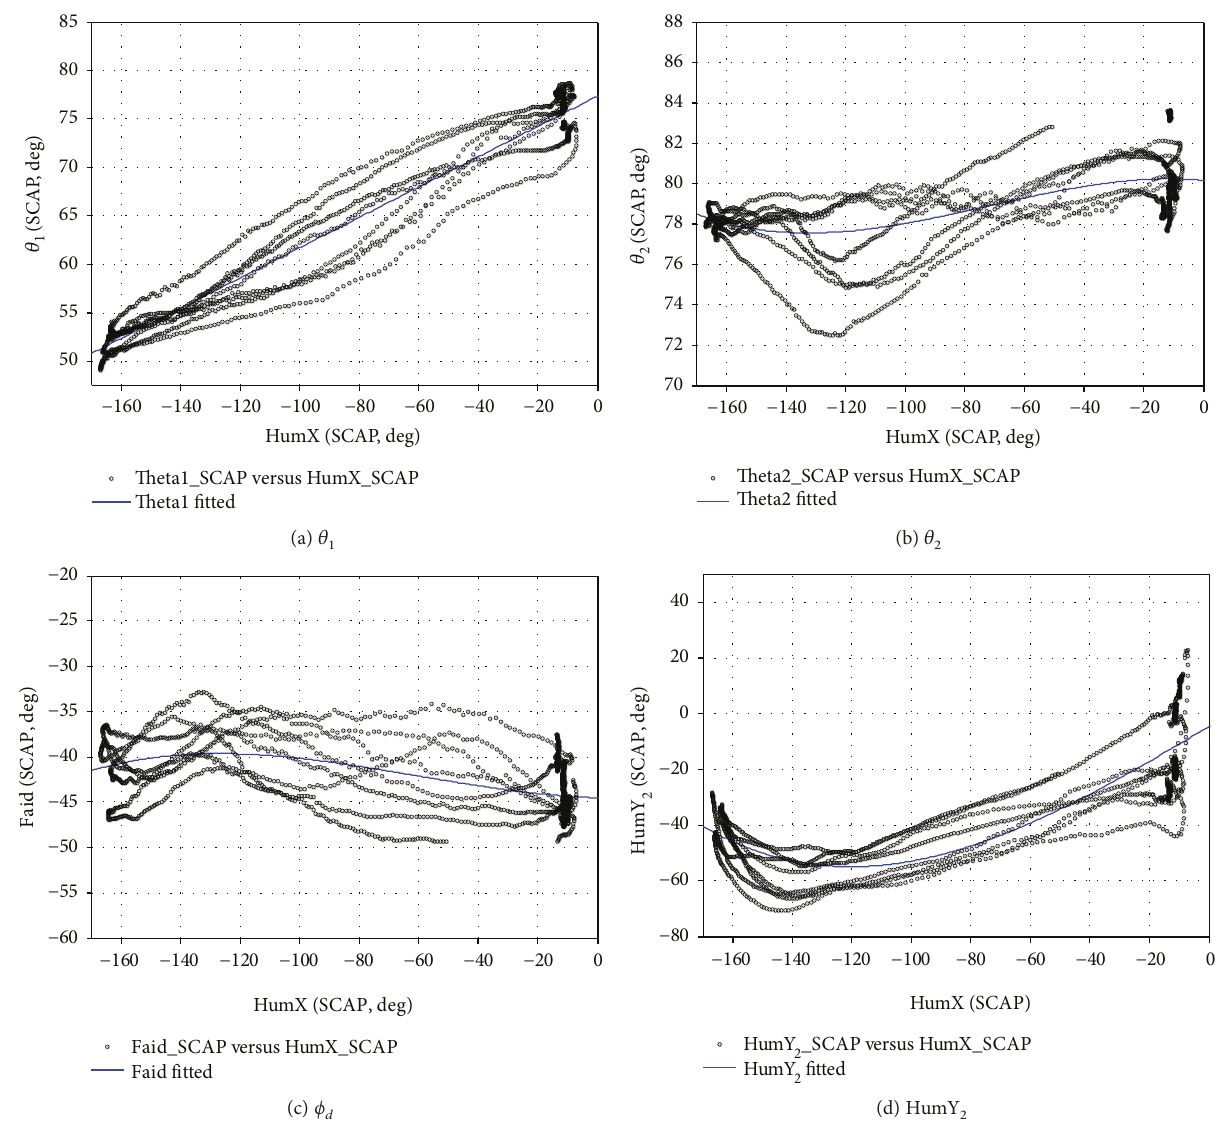
Figure 20: The joint angles are fi t using a third-order polynomial (SCAP). Table 6: Third-order polynomial fi t parameters of the rhythm function